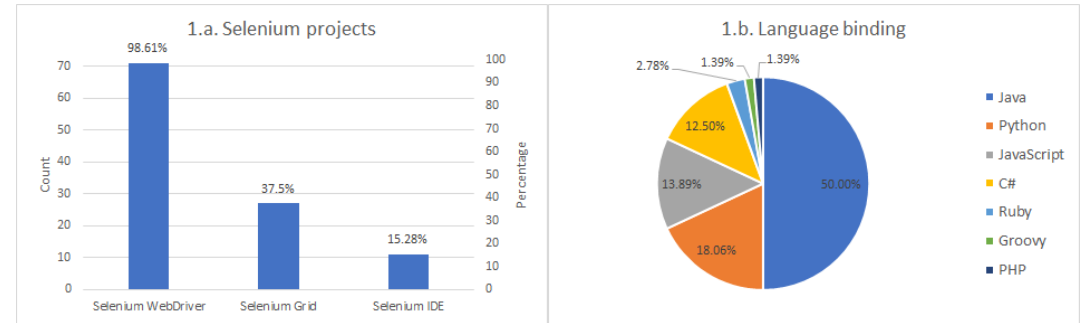
Figure 6. Selenium projects and language